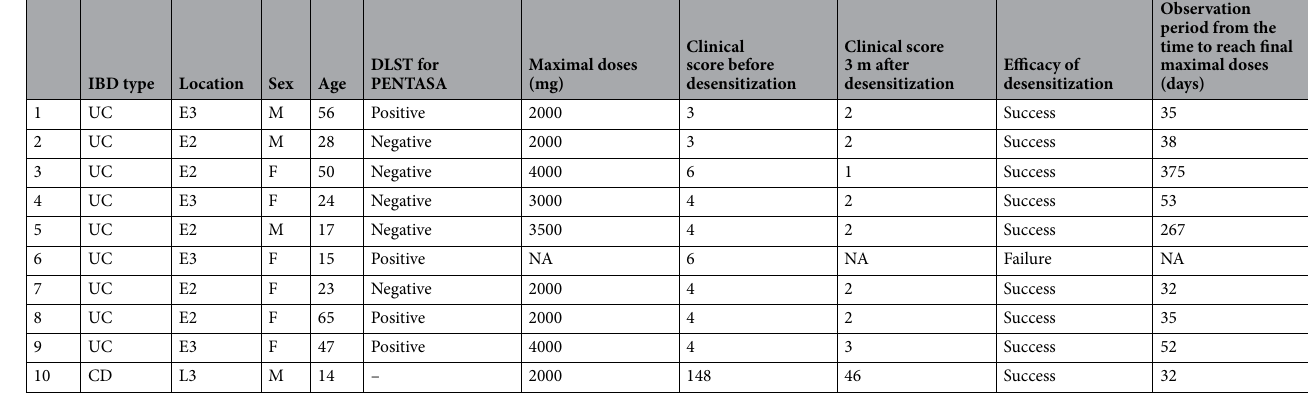
Table 4. Clinical course of ten patients that underwent desensitization protocol with time dependent- mesalazine granules. Disease extent in UC is classified as proctitis [E1], left-sided [E2] or extensive colitis [E3]. Disease location in CD is classified as ileum [L1], colon [L2] or ileocolon